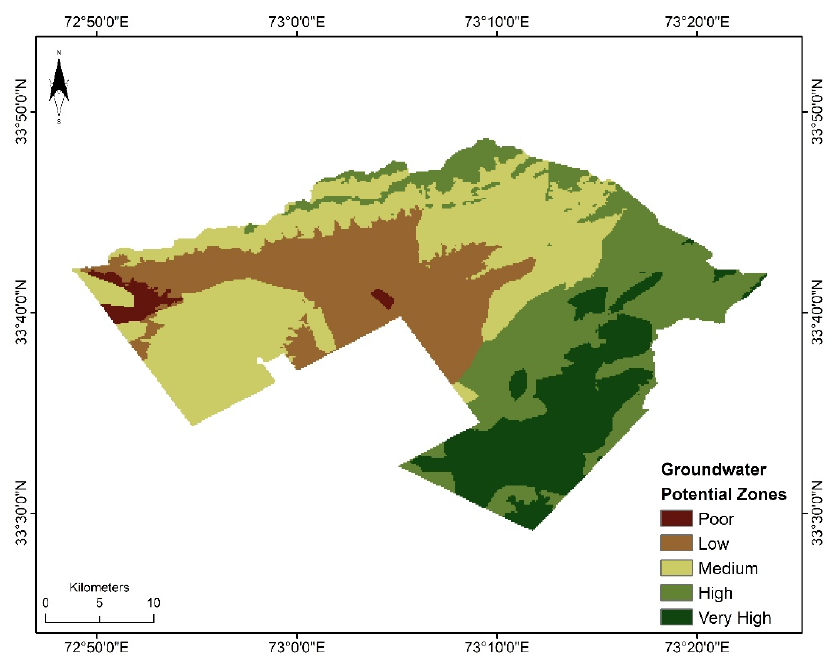
Figure 4. Potential groundwater recharge zones in the study area.